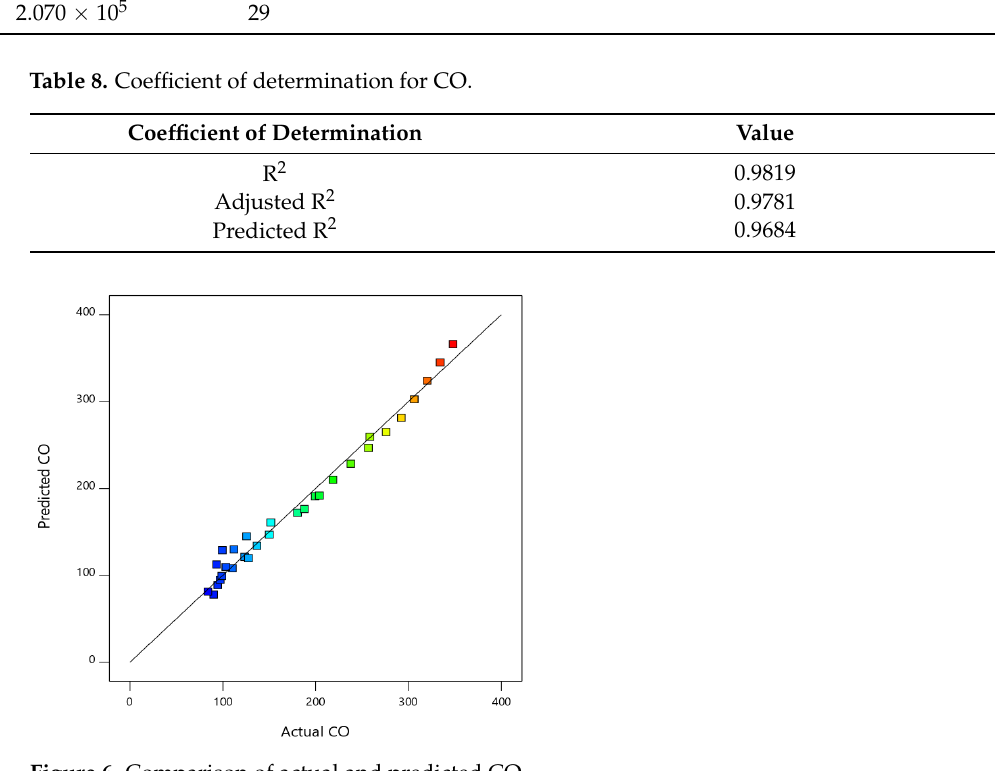
Figure 6. Comparison of actual and predicted CO.